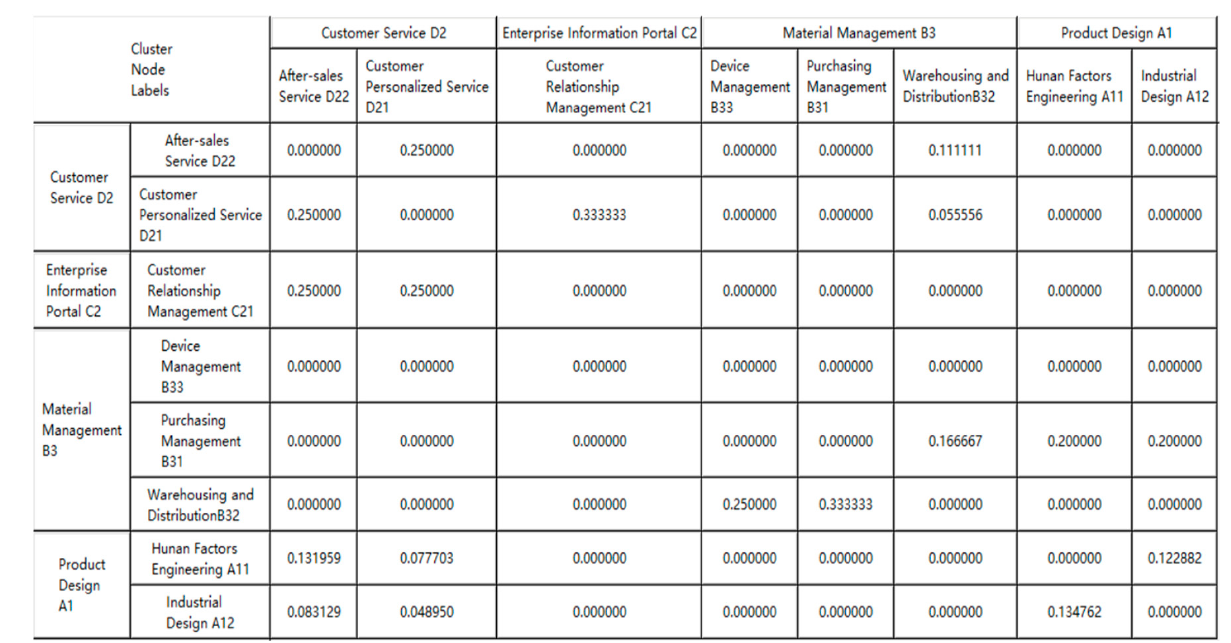
Figure 8. Weighted hypermatrix derived from SD software (partial data).